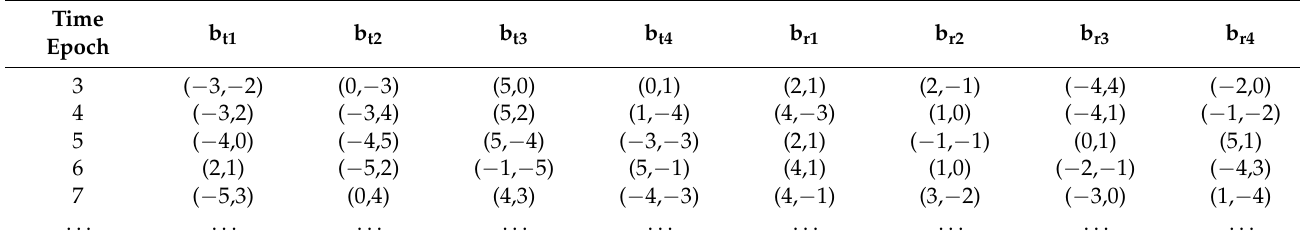
Figure 5. Computational complexity comparison. Table 3. Antenna selection of the proposed method in one trial.